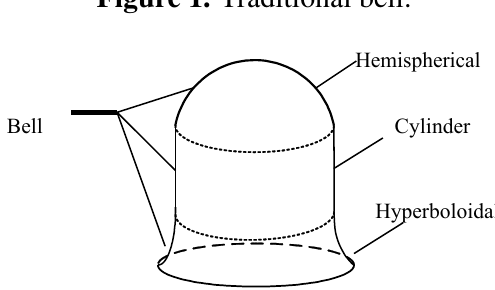
Figure 2. Cross-section of bell-shaped resonator with a variable thickness axisymmetric